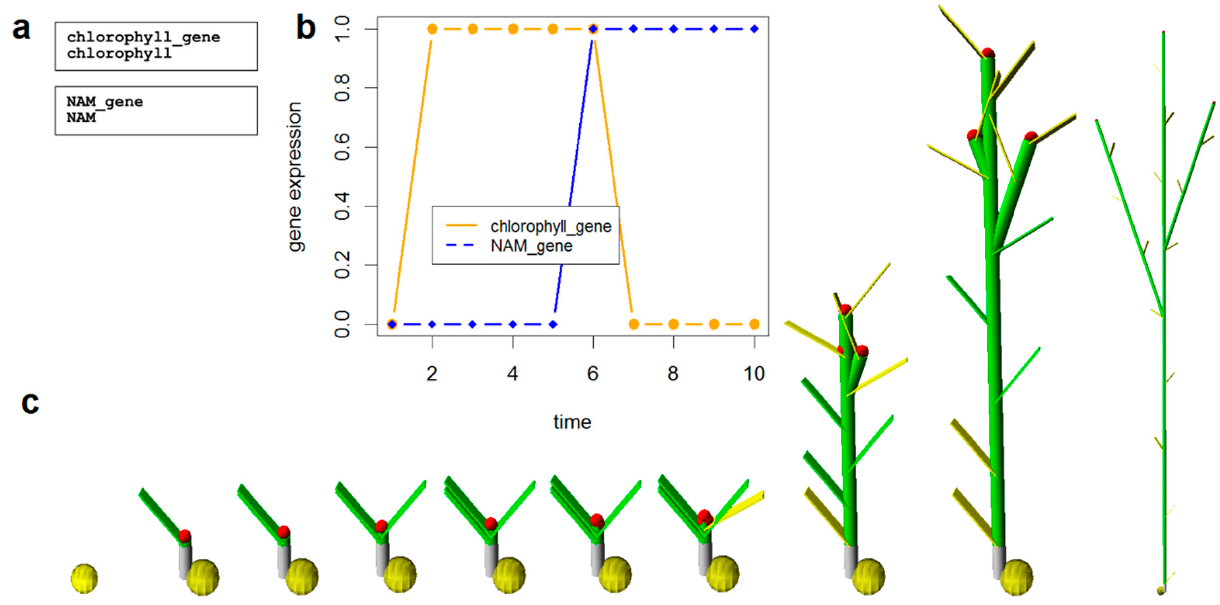
Figure 3. Modelling the senescence phenotype using an alternative strategy with ( a ) two hypothetical genes, ( b ) when the NAM gene is upregulated, the chlorophyll is downregulated, and therefore senescence is triggered, which is also graphically modelled in ( c ), where the model plant starts to become yellow at step number 7 (or 6 beginning from emergence).